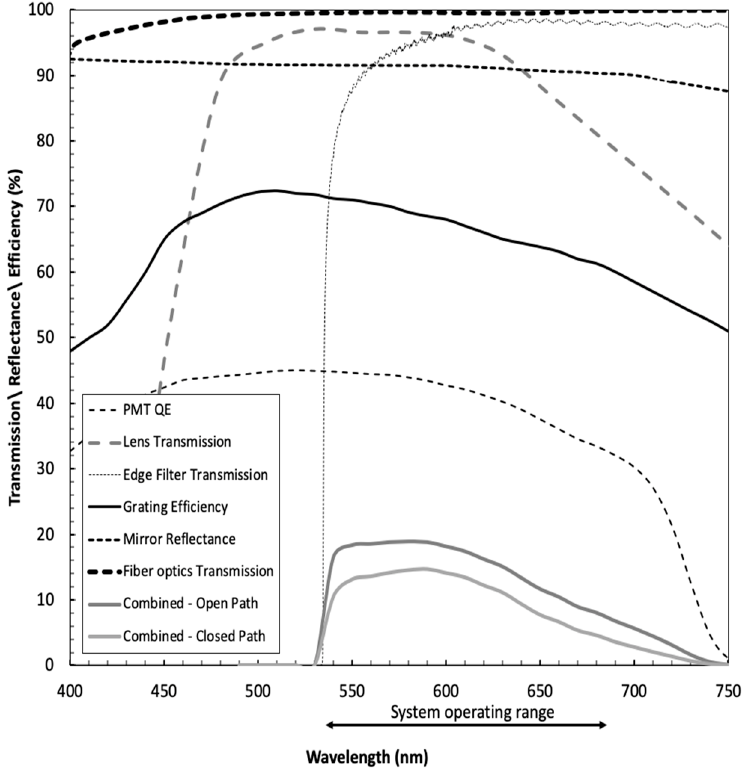
Figure 8. Composite curve of inbound- and outbound-path optics, monochromator grating and mirrors, and the PMT quantum efficiency for open path system compared to closed-path system.